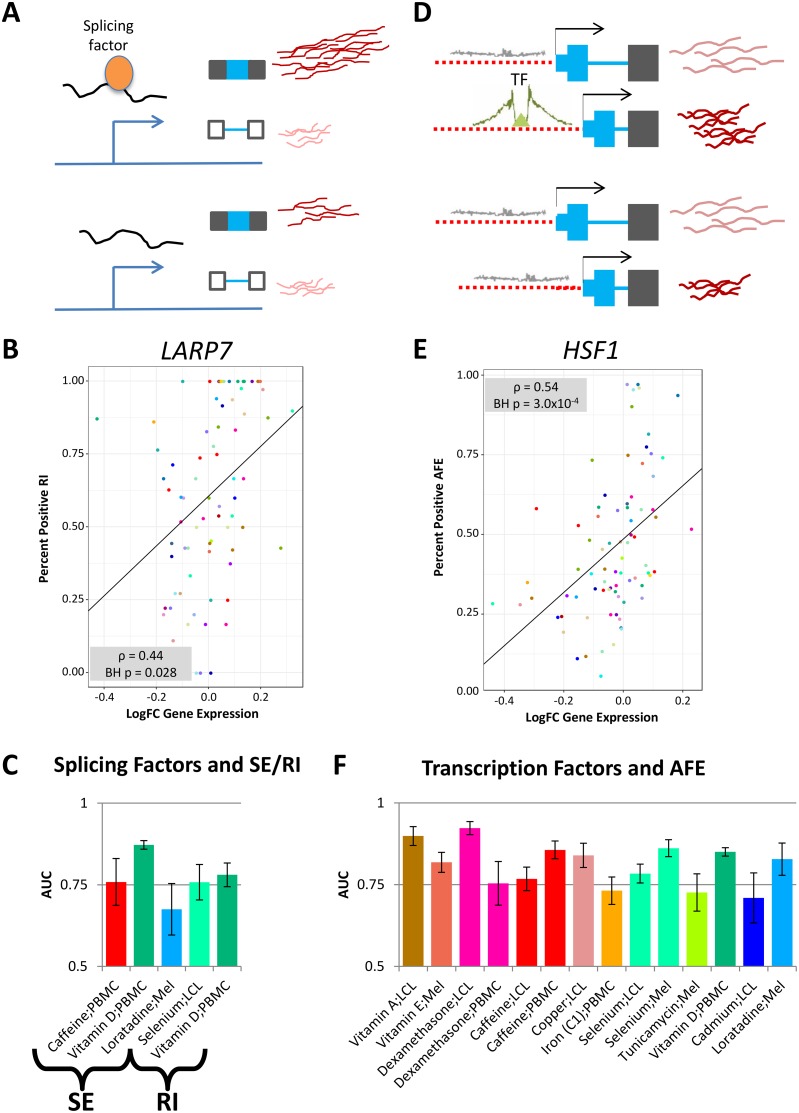
Effect of trans-factor binding on RNA processing shifts.A) and D) show models of hypothesized mechanism of splicing or transcription factor influence on RNA processing and exon usage. B) An example of a correlation between the changes in gene expression of an RNA processing factor (LARP7) and the percent of RIs that shift towards the intron retention across all environments for which gene expression could be assessed. E) An example of a correlation between the changes in gene expression of a transcription factor (HSF1) and the percent of AFEs that shift towards the upstream AFE across all environments for which gene expression could be assessed. The correlation for B) and E) was tested using Spearman’s rho and the p-value shown is Benjamini-Hochberg corrected while the trendline depicts the best-fit line. C) Graph indicating the predictability (AUC as a proxy) of SE or RI shifts in a certain environment given predicted splicing factor binding sites (RNAcompete). F) Graph indicating the predictability (AUC as a proxy) of AFE shifts in a certain environment given transcription factor footprints [48].